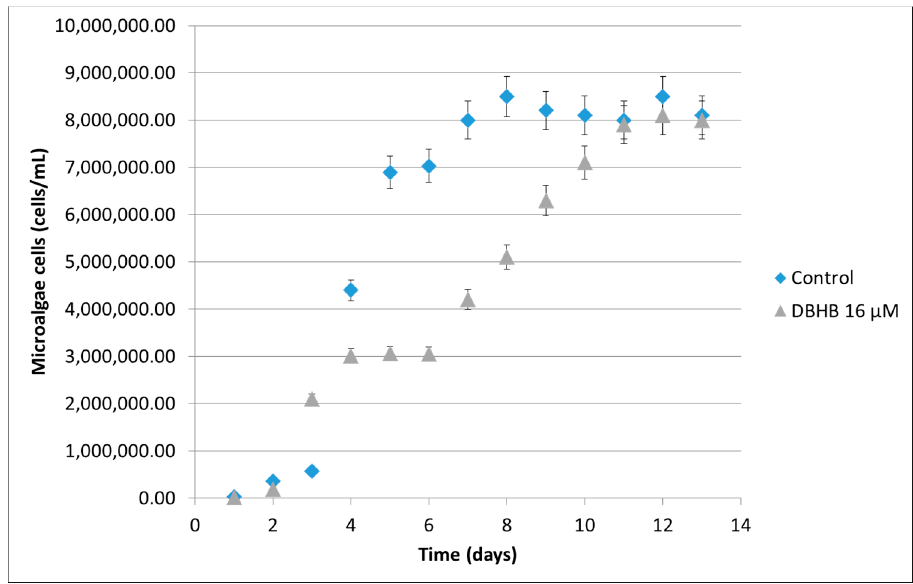
Figure 3. Influence of DBHB (16 μ M) on bacterial growth. Data represent the mean ± standard deviation of replicates.